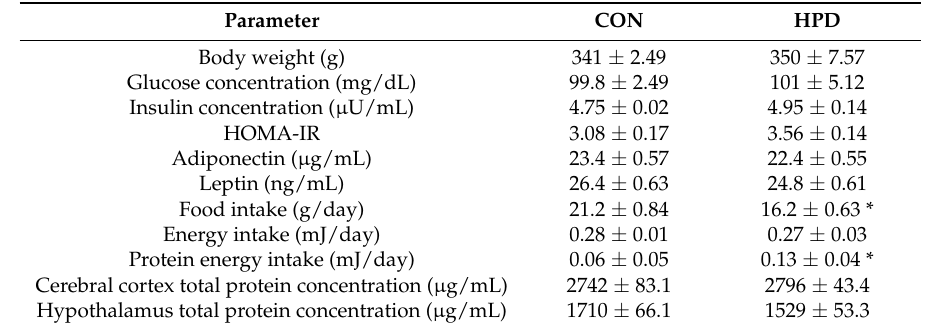
Table 1. Effect of 8-week HPD on rats’ body weight, plasma glucose, insulin, adiponectin, leptin, total protein concentration, food, and energy